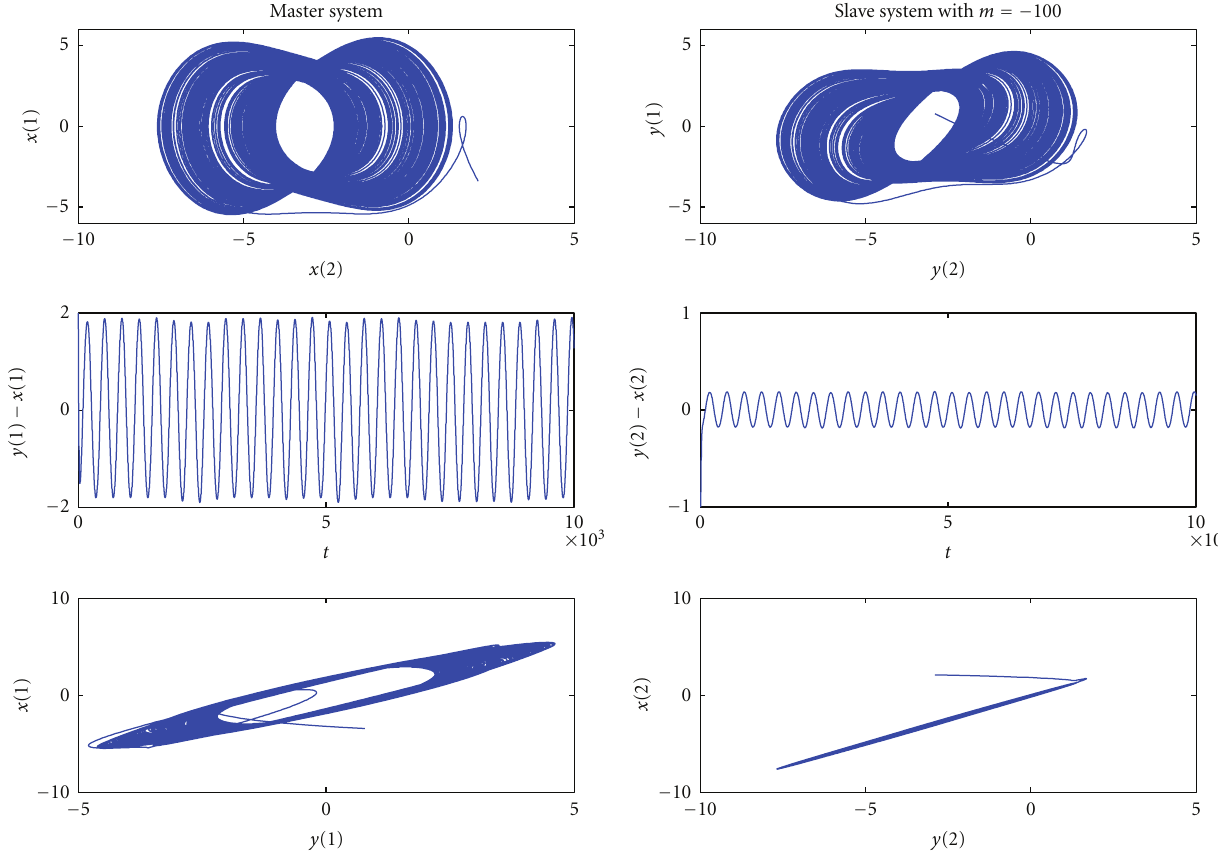
Figure 2: Phase portrait, errors, and similarity of unidirectional coupled systems with k = − 10 and m = − 100